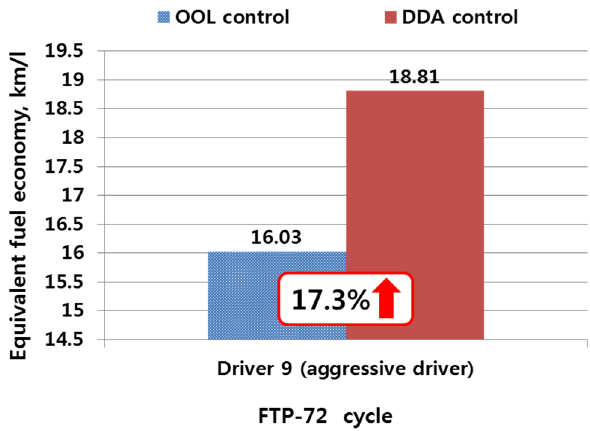
Figure 18. Comparison of the equivalent fuel economy for the OOL control and the DDA